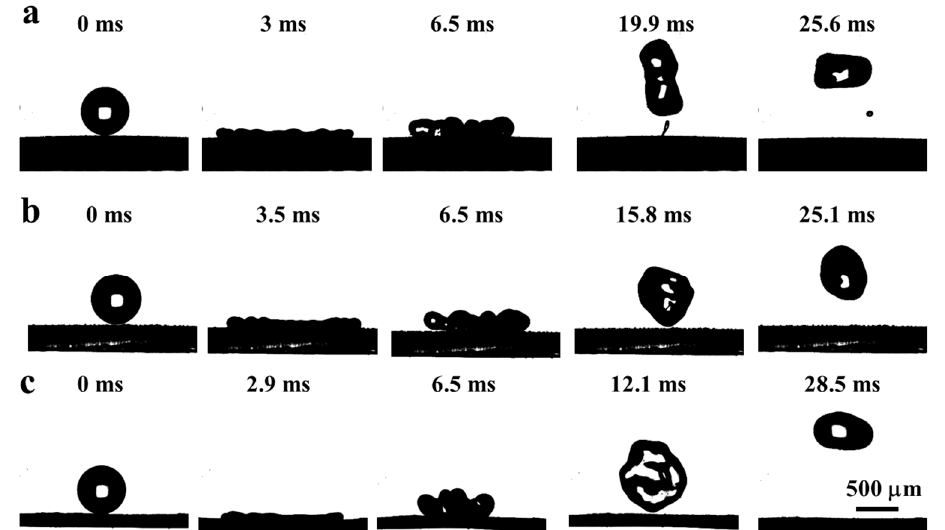
Figure 5. Droplet impacting the cold ( a ) rigid superhydrophobic surface and ( b – c ) elastic superhydrophobic membranes with stiffness k = 5.21 N/m and k = 0.65 N/m at a speed of 1.5 m/s.